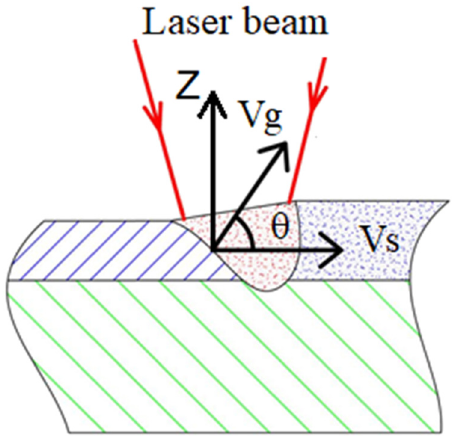
Figure 8: Schematic of melt pool